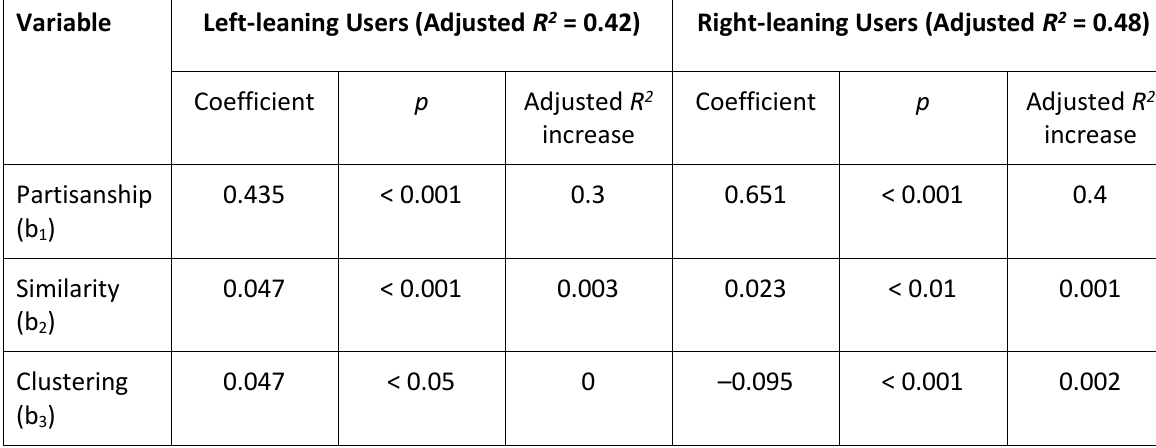
Table 1. Regression results: effects of the three independent variables on the vulnerability to online misinformation for left- and right-leaning users. Along with the coefficients, we show p-values and adjusted R 2